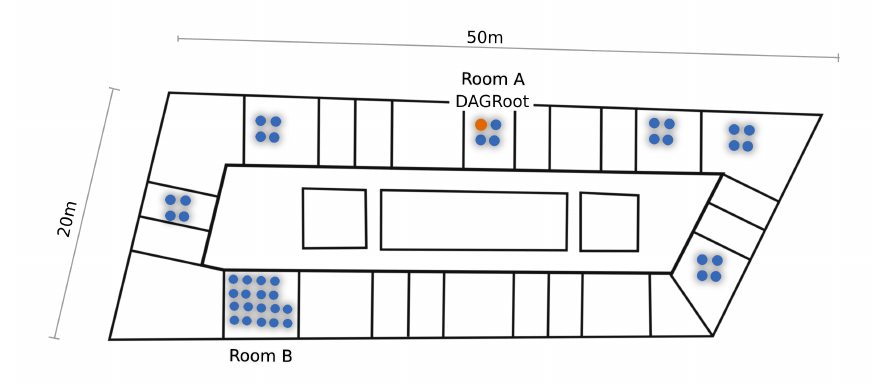
Figure 2. Locations of the 42 motes of the OpenTestbed across an office floor at